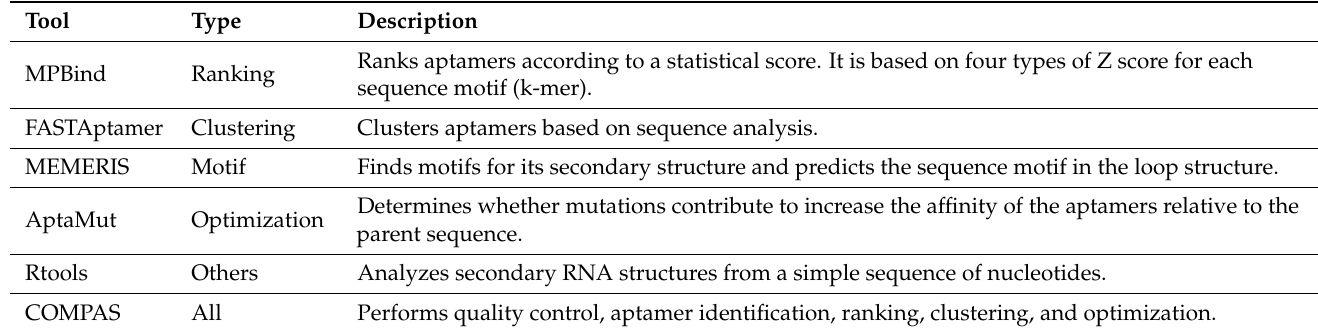
Table 3. The main tools used for the design of RNA aptamers in